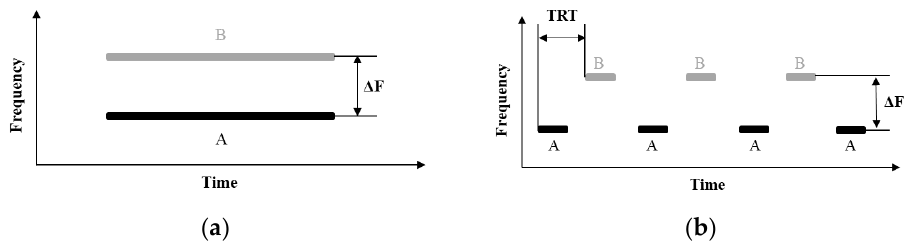
Figure 4. The schematic spectrogram of the stimuli used in two experiments: ( a ) simultaneous organization experiments, where A and B indicate two concurrent tones with different frequency intervals (ΔFs). ( b ) sequential organization experiments, where alternating tones A and B indicate two tones with different frequency intervals (ΔFs) and tone repetition times (TRTs).